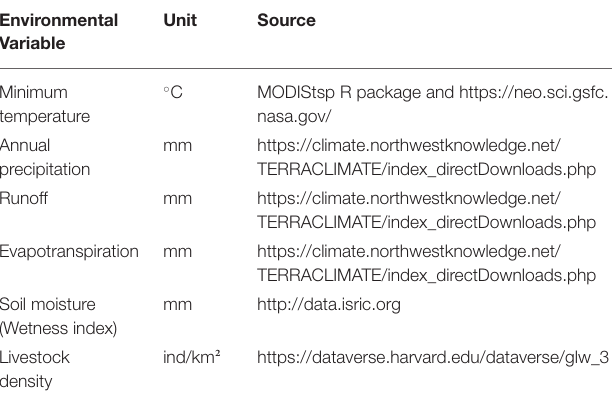
TABLE 1 | Variables used for the NSDv ecological niche